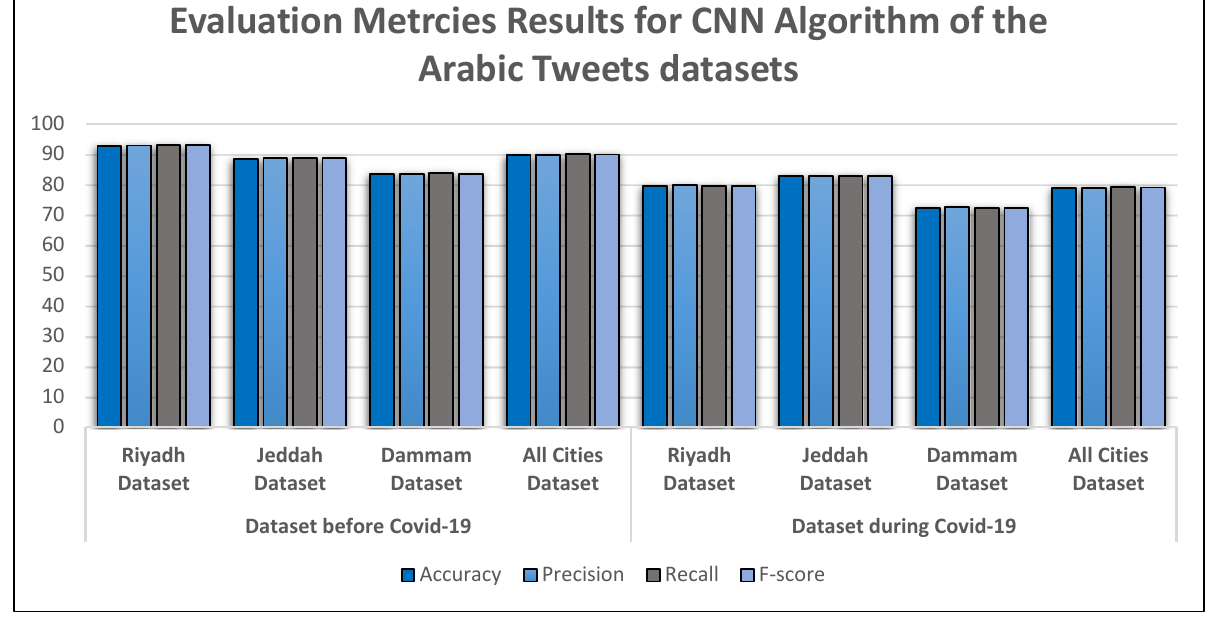
Figure 11 . The Chart of Results of the CNN algorithm for all datasets. Figure 11. The Chart of Results of the CNN algorithm for all